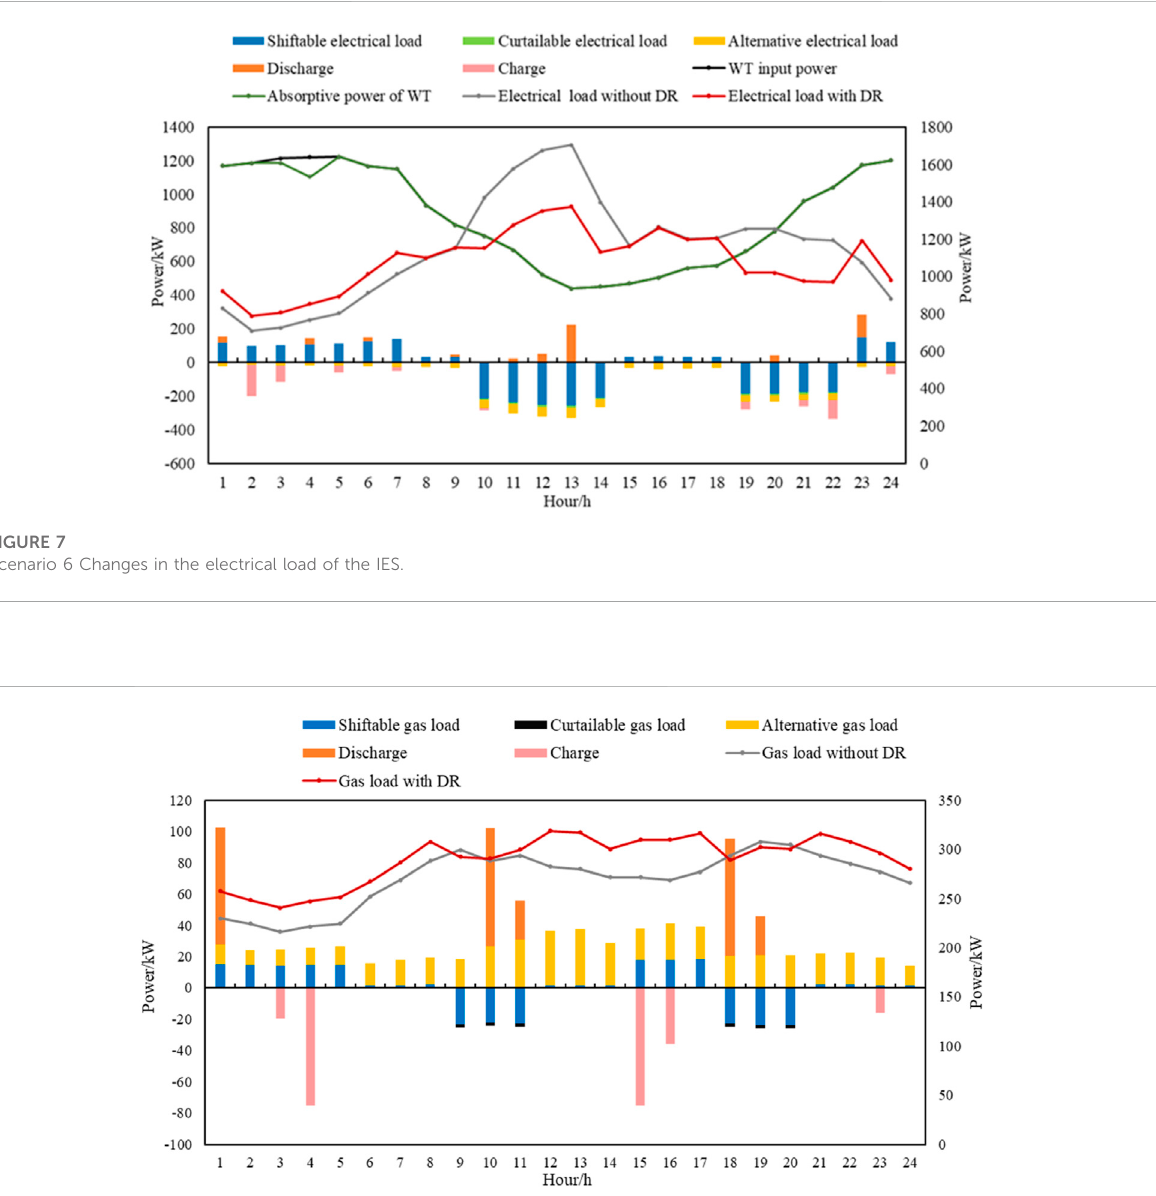
FIGURE 8 Scenario 6 Changes in the gas load of the